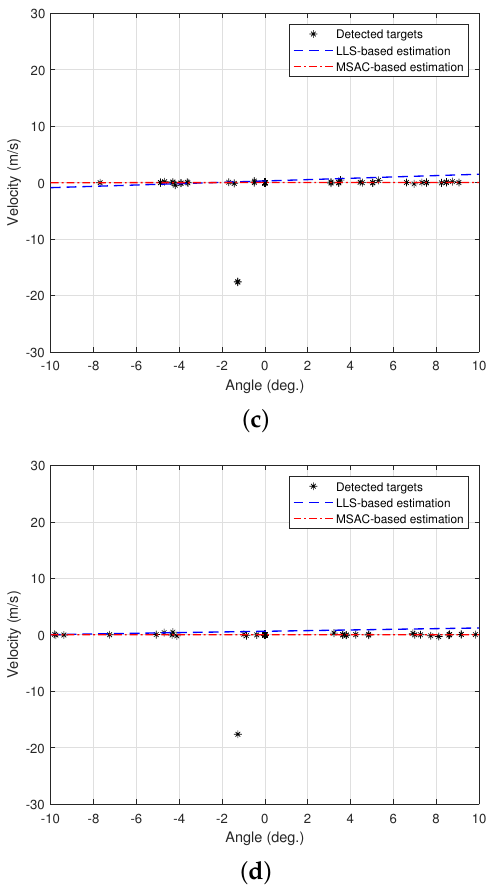
Figure 9. Estimation results for successive detection results: ( a ) t = 0 (ms); ( b ) t = 33 (ms); ( c ) t = 66 (ms); ( d ) t = 99 (ms).